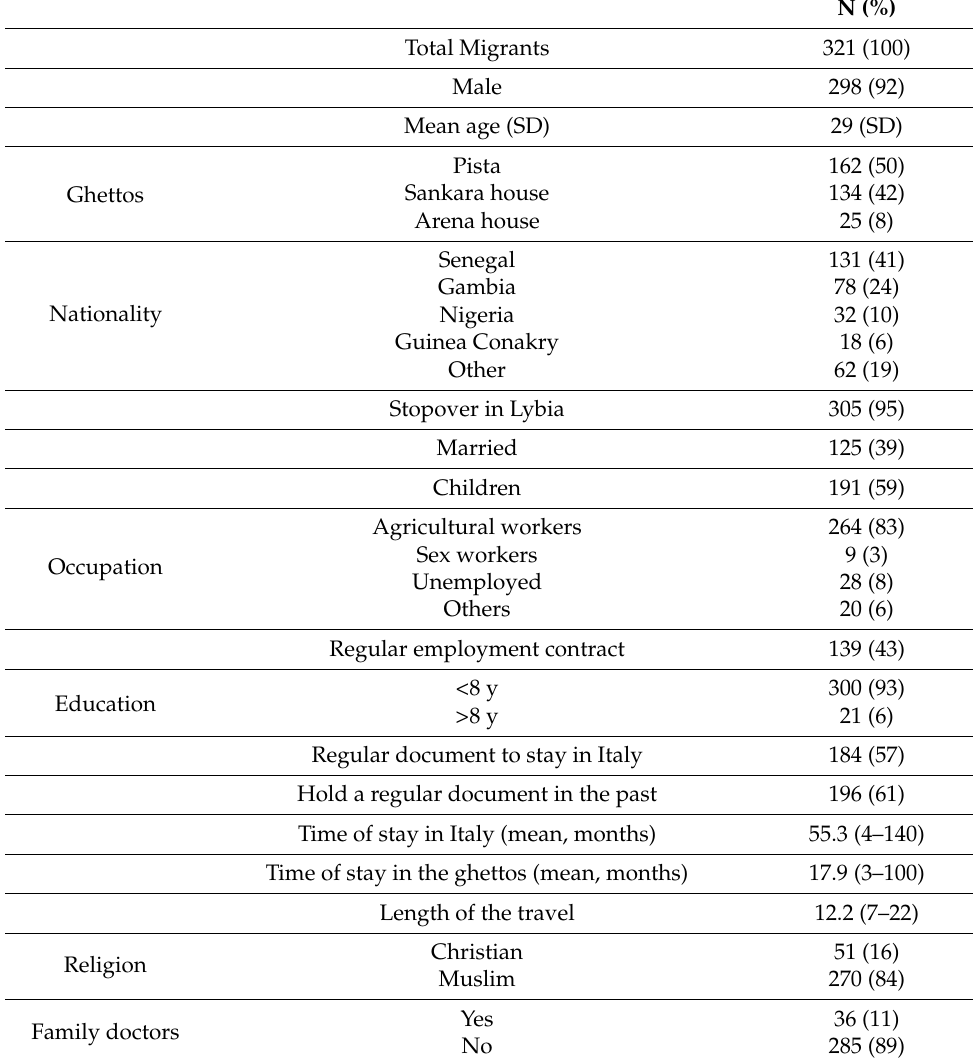
Table 1. Socio-demographic information of the 321 migrants enrolled in the